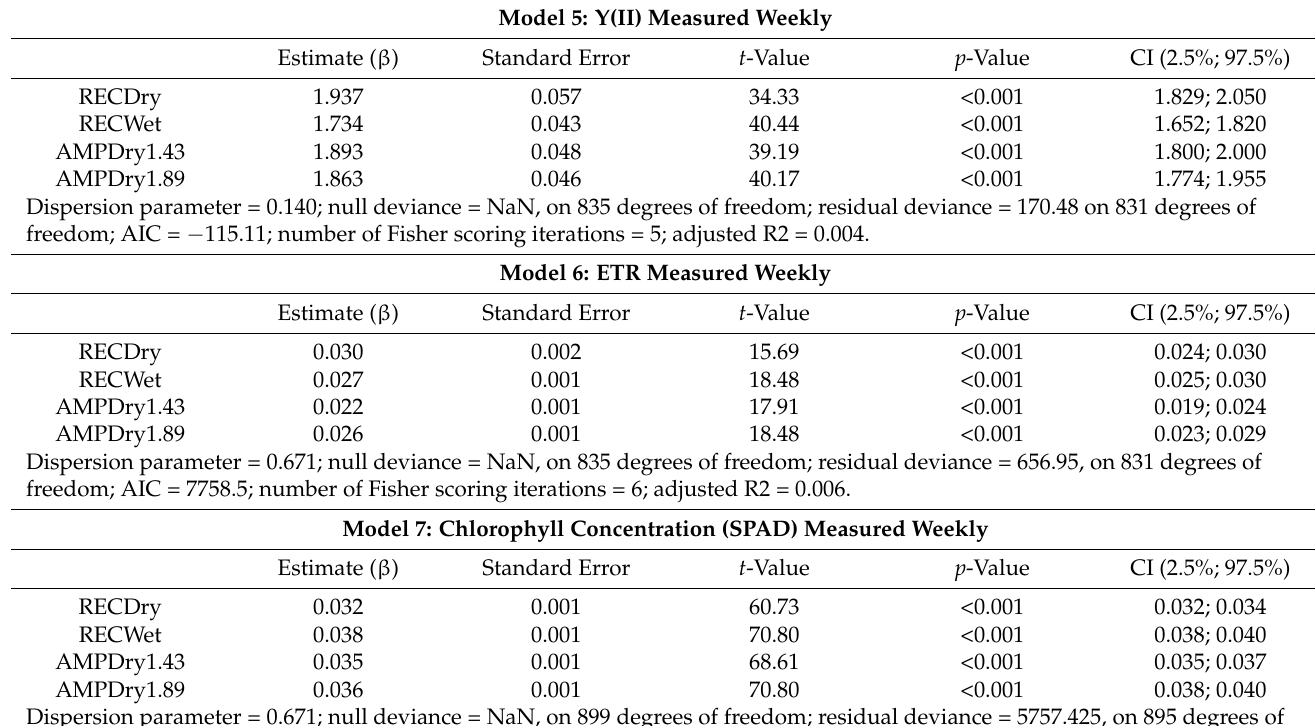
Table 4. Estimated regression parameters, standard errors, coefficients and p -values for 3 gamma GLMs. Model 5: Y(II) Measured